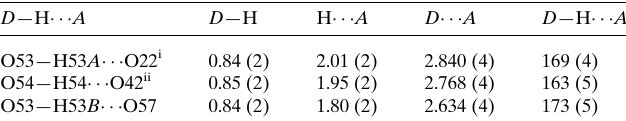
Table 1 Hydrogen-bond geometry (A˚ , (cid:4) ).